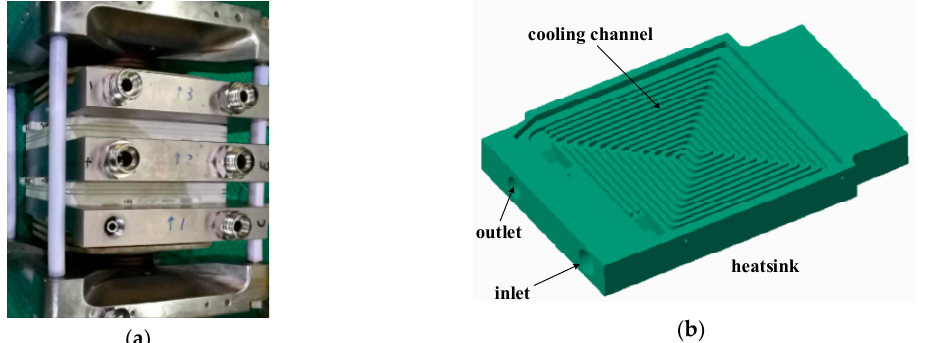
Figure 6. Double-sided cooling configuration: ( a) Mechanical press-pack stack; ( b ) Internal structure of heatsink.